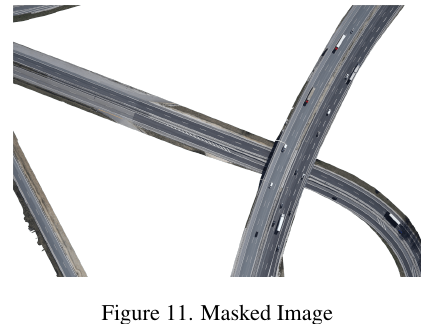
Figure 11. Masked Image